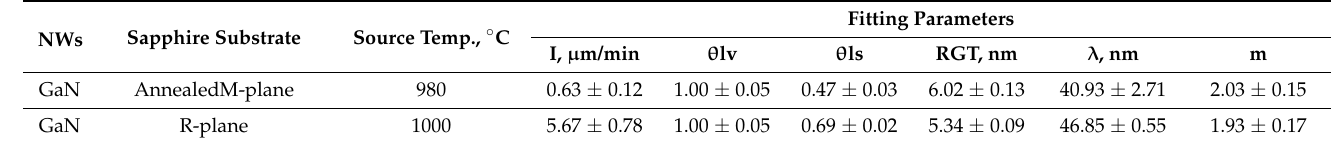
Table 1. Fitting parameters of GaN